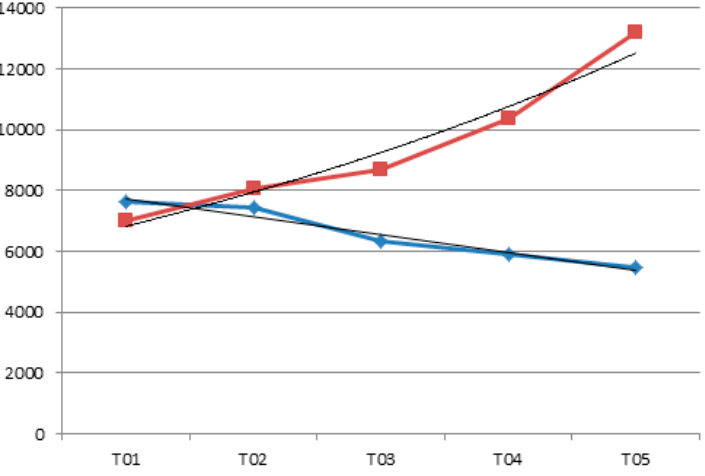
Figure 5. Evolution of arsenic during field